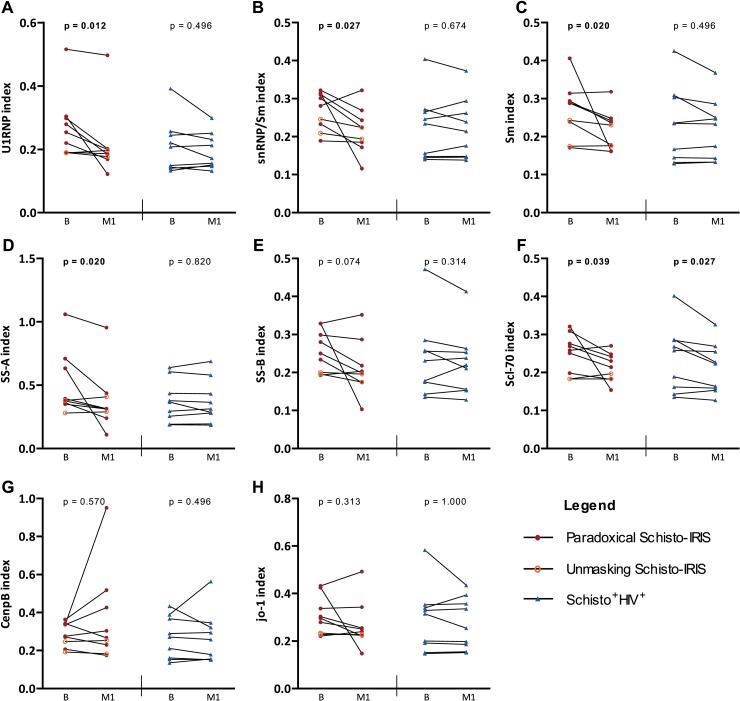
Time analysis of 8 anti-nuclear antibodies.Graphs show semi-quantitative values of plasma levels of ANAs, calculated as a ratio of positive cut-off control (index value). Index values of (A) U1 snRNP, (B) snRNP/Sm complex, (C) Sm, (D) SS-A, (E) SS-B, (F) Scl 70, (G) CenpB and (H) Jo-1 before and during 1 month of ART are shown in Schisto-IRIS patients (red circles) and Schisto+HIV+ controls (blue triangles). The significant change over time for each patient group was calculated using the Wilcoxon-signed rank test (p-values shown in graphs). B = baseline, M1 = month 1.